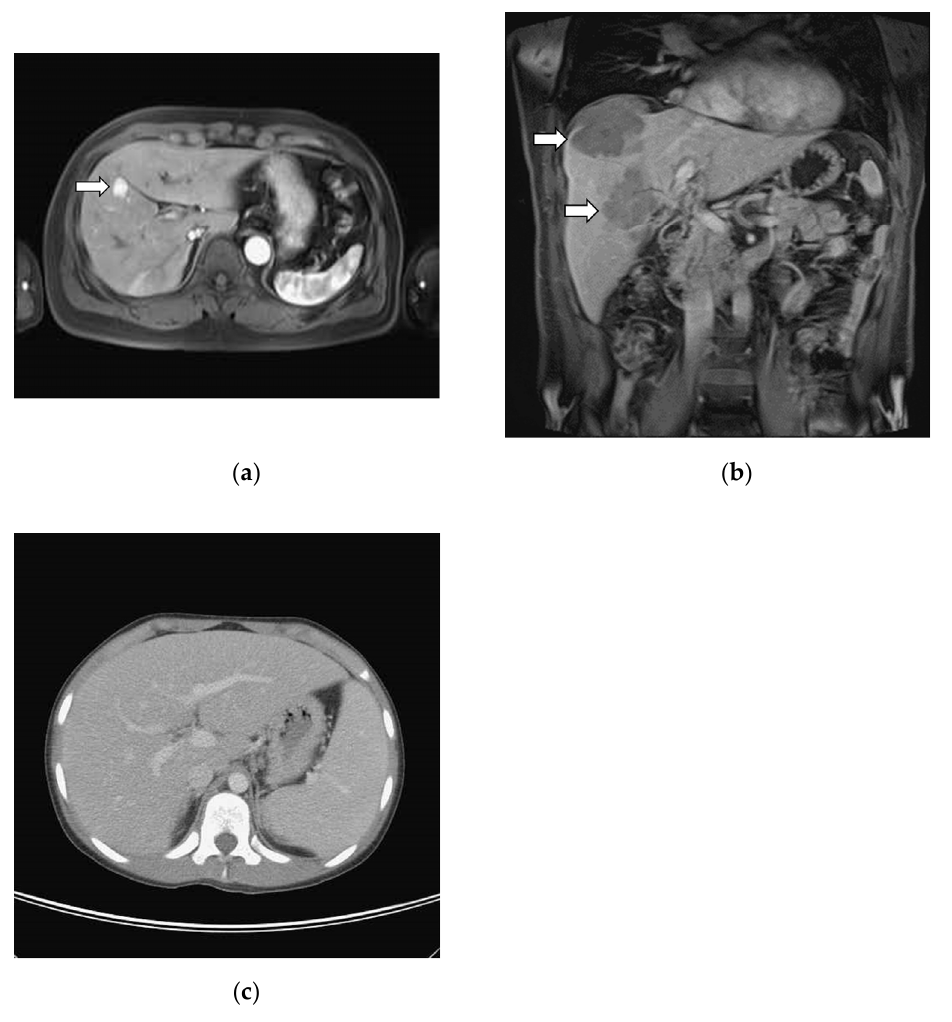
Figure 1. Variable radiographic findings in primary hepatic lymphoma: ( a ) Abdominal magnetic resonance imaging (MRI) axial T1-weighted fat-saturated image with contrast enhancement, arterial phase. MAGNETOM SymphonyTim 1.5T MRI scanner (Siemens, Erlangen, Germany) . This case underwent segmental resection and final diagnosis is primary liver low grade follicular lymphoma (Figure 2a,b). Patient is still alive without evidence of disease 7 years after initial diagnosis; ( b ) Abdominal MRI coronal T1-weighted fat-saturated image with contrast enhancement, venous phase, from 55-year-old male. MAGNETOM Aera 1.5T MRI scanner (Siemens, Erlangen, Germany) . Multiple liver mass lesions (arrow) were found but no other lymphadenopathy. Biopsy of liver showed diffuse large B cell lymphoma, germinal center B phenotype. Patient was treated with R-CHOP in partial response and was alive 3 years after initial diagnosis; ( c ) Abdominal computed tomography axial image with contrast enhancement, venous phase. Brilliance 64 CT scanner (Philips, Cleveland, OH, USA) . Apparent hepatomegaly and splenomegaly noted from 12-year-old body. Random liver biopsy had sinusoidal atypical T lymphocytes infiltration and clonality studies for TCR-gamma was clonal. Final diagnosis is hepatosplenic T cell lymphoma. Patient is alive without disease 8 years after initial diagnosis.